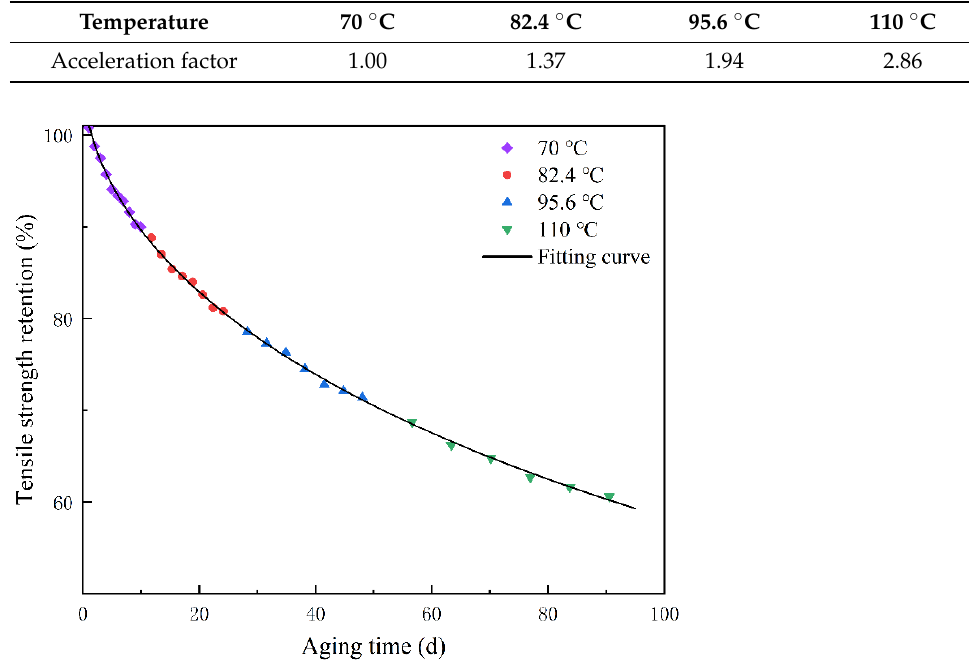
Figure 5. Aging data and nonlinear regression after time – temperature equivalent superposition.